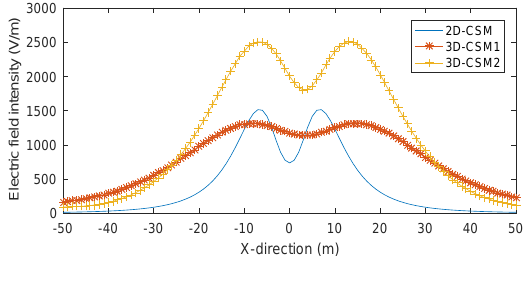
Figure 10. Comparison diagram of electric field intensity.